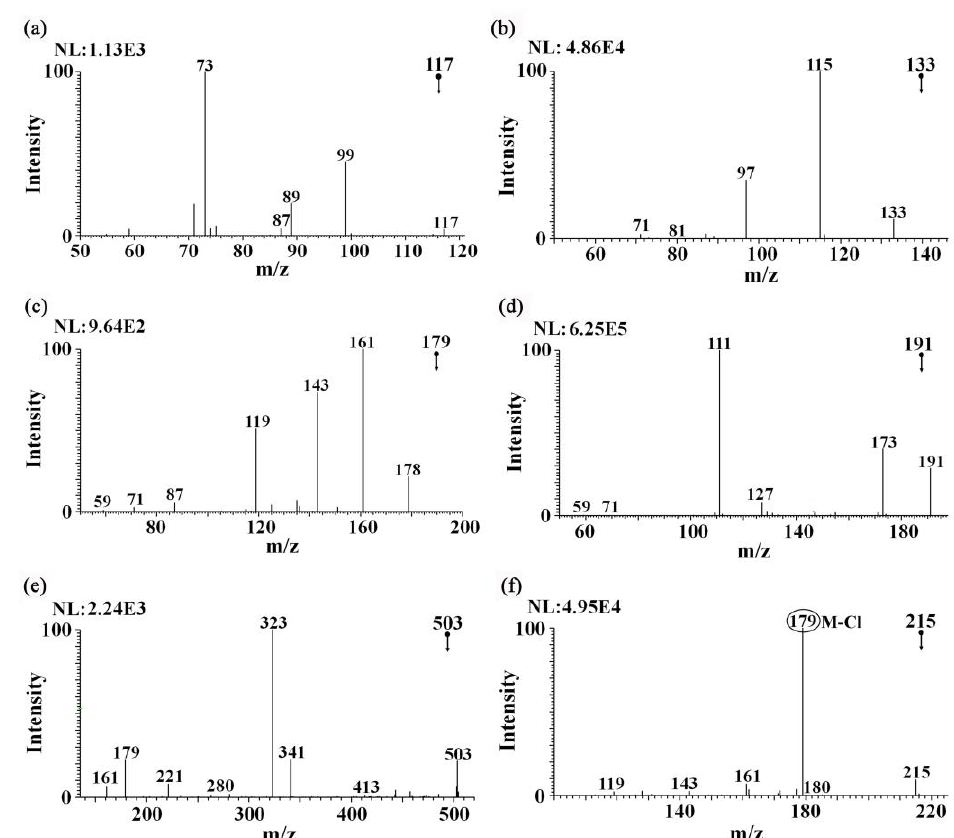
Figure 4. Tandem MS analysis of characteristic ions of the active components in the ginseng under forest and two Panax quinquefolium samples detected with iEESI-MS: ( a ) MS 2 spectrum of m / z 117 → , ( b ) MS 2 spectrum of m / z 133 → , ( c ) MS 2 spectrum of m / z 179 → , ( d ) MS 2 spectrum of m / z 191 → , ( e ) MS 2 spectrum of m / z 503 → , and ( f ) MS 2 spectrum of m / z 215 → .